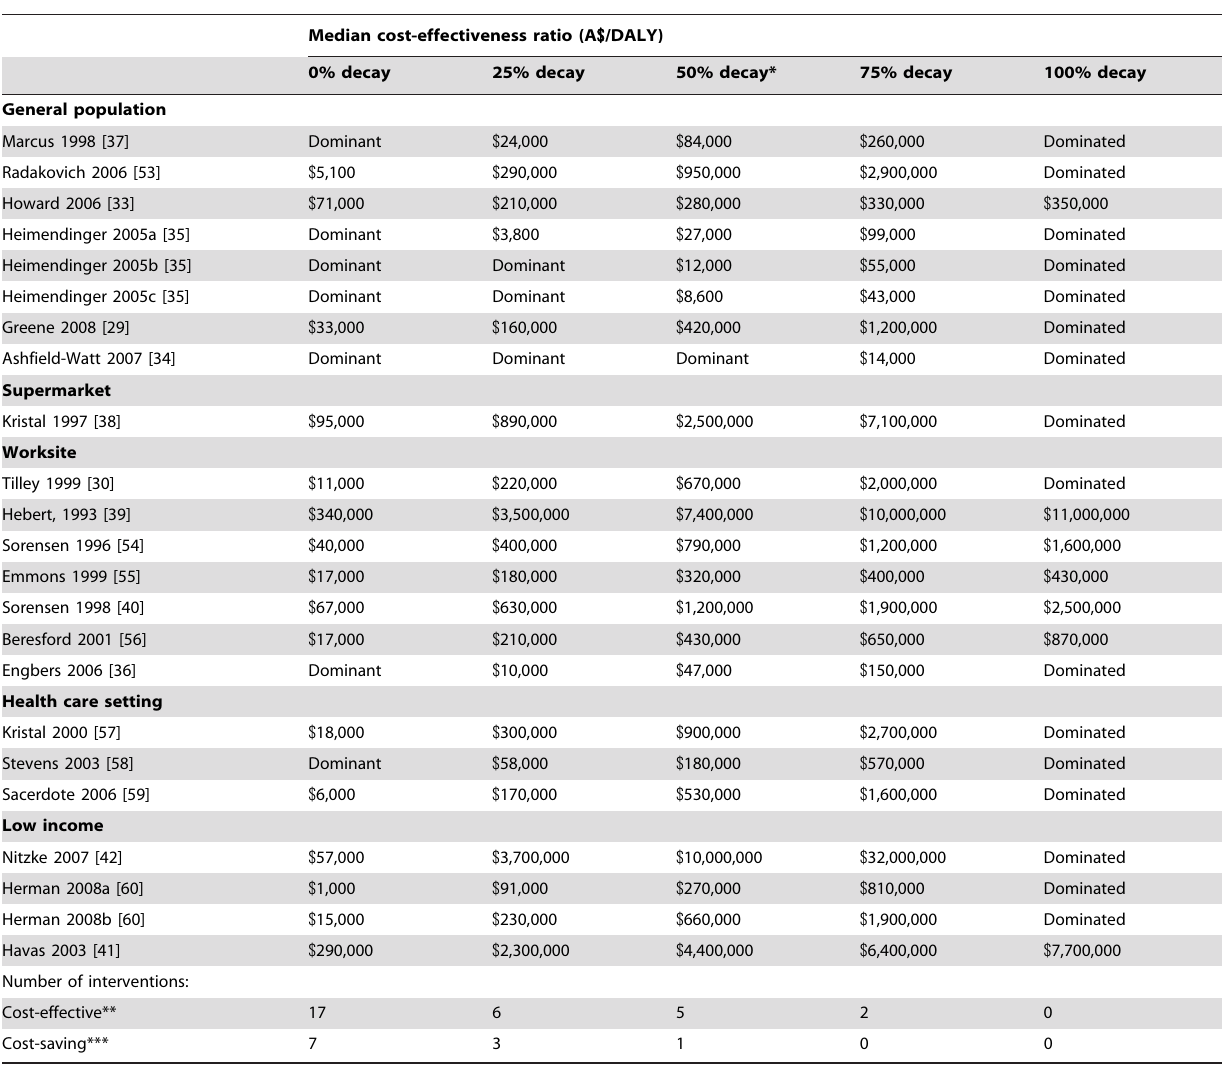
Table 5. Sensitivity of intervention cost-effectiveness to rates of decay in intervention effectiveness between 0% (life-long health benefits from one-off intervention) and 100% (no health benefits beyond the end of